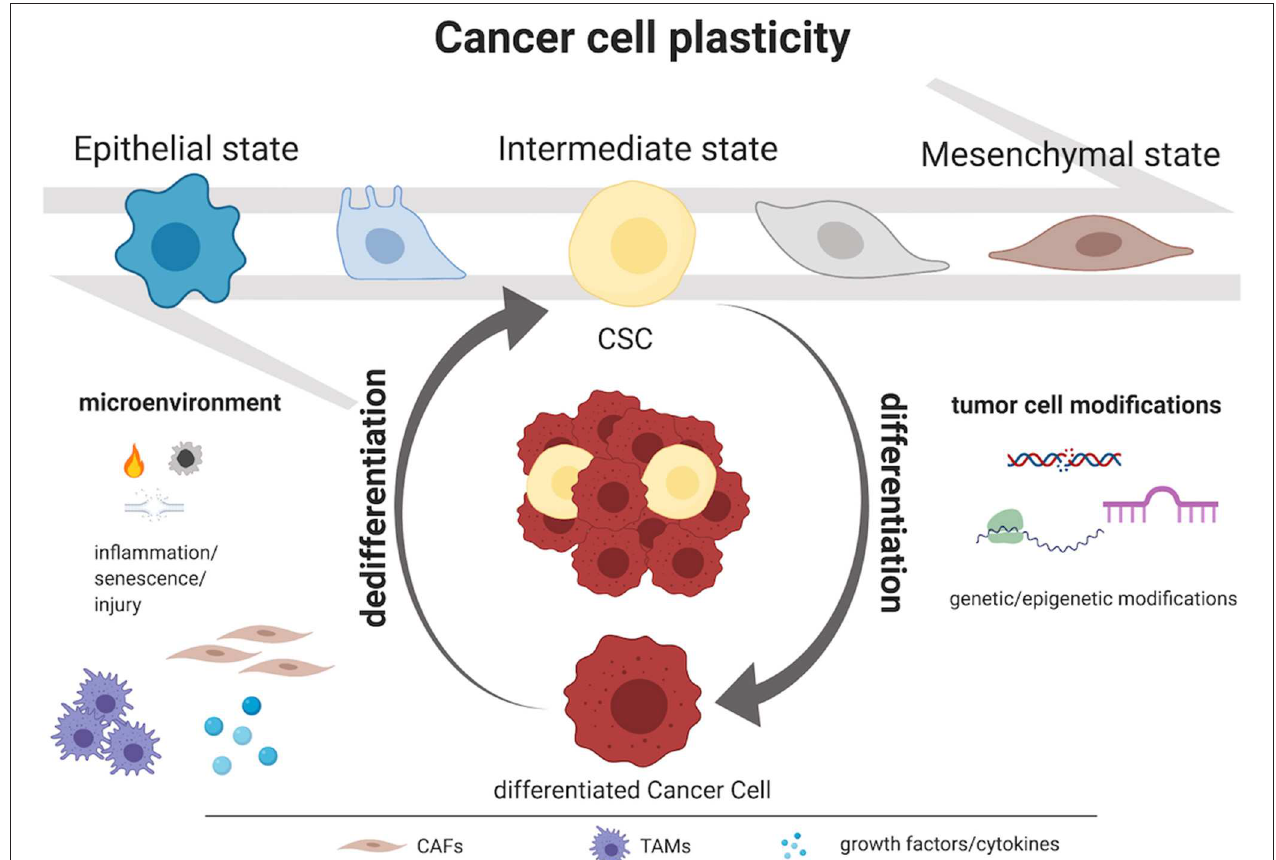
FIGURE 1 | Mechanisms governing CSC plasticity model. Intra-tumor heterogeneity relies on the capacity to shift dynamically and reversibly between CSC and non-CSC/differentiated state. Tumor cell modifications as genetic and epigenetic alterations and microenvironment perturbations as inflammation, injury, and senescence represent the major causes of cancer cells plasticity. Moreover, CSCs exhibit an induced epithelial-to-mesenchymal transition (EMT) program and, particularly, they display an intermediate state of EMT. This process depends on both genetic mutations, epigenetic modifications and transcriptional modulation of cancer cells and signals provided by the tumor microenvironment (i.e., growth factors, cytokines, CAFs or TAMs). Created with